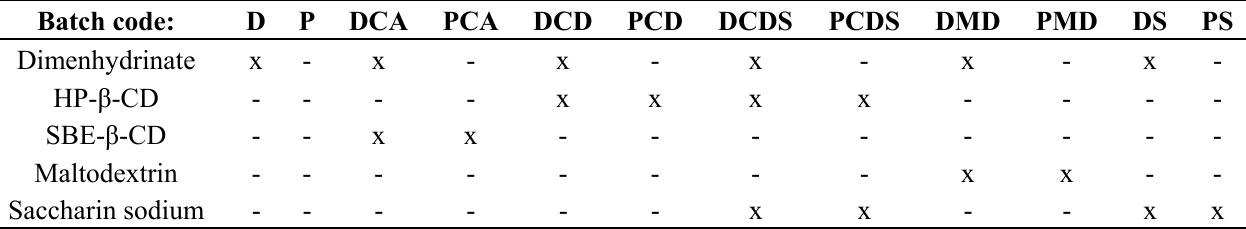
Table 2. Dimenhydrinate and drug-free formulations (x indicates that the particular ingredient is included in the